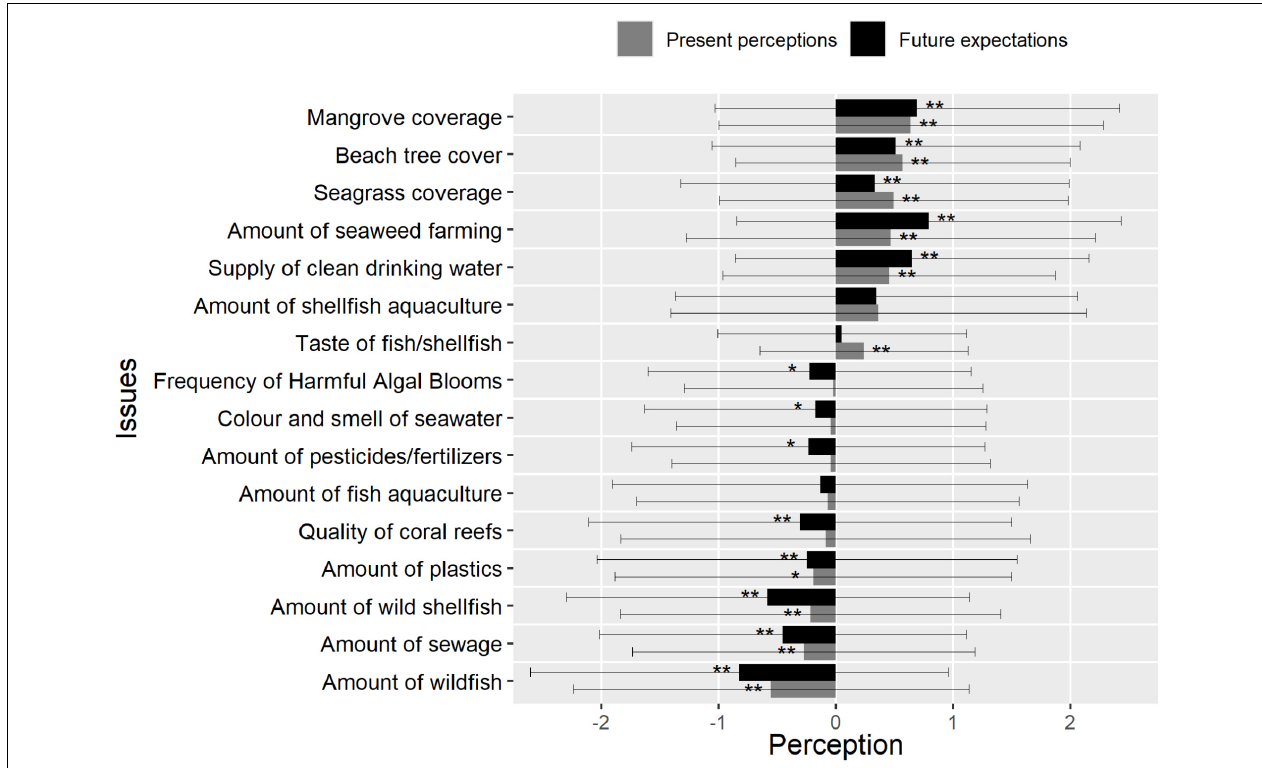
FIGURE 2 | Response of respondents to questions, “What do you think of the following compared to 10 years ago?” (Present perception) and “What do you think of the following in the next 10 years compared to now?” (Future expectation) with the following options (the x axis): –3 is much worse, –2 is worse, –1 is slightly worse, 0 is the same, 1 is slightly better, 2 is better, and 3 is much better. Issues with ** are areas where high significant differences were observed ( p < 0.01). Issues with * are areas where significant differences were observed ( p <